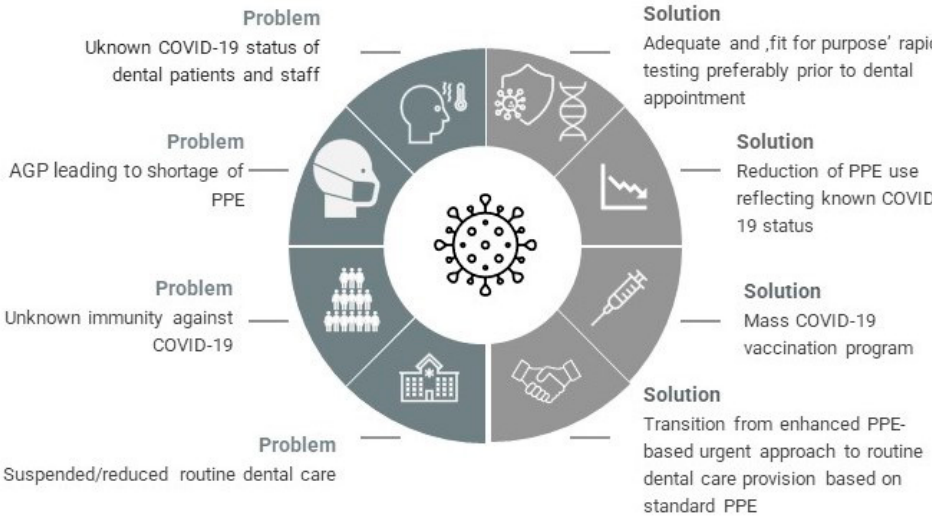
Figure 5. Resuming dental practice during the COVID-19 pandemic. Challenges and solutions.